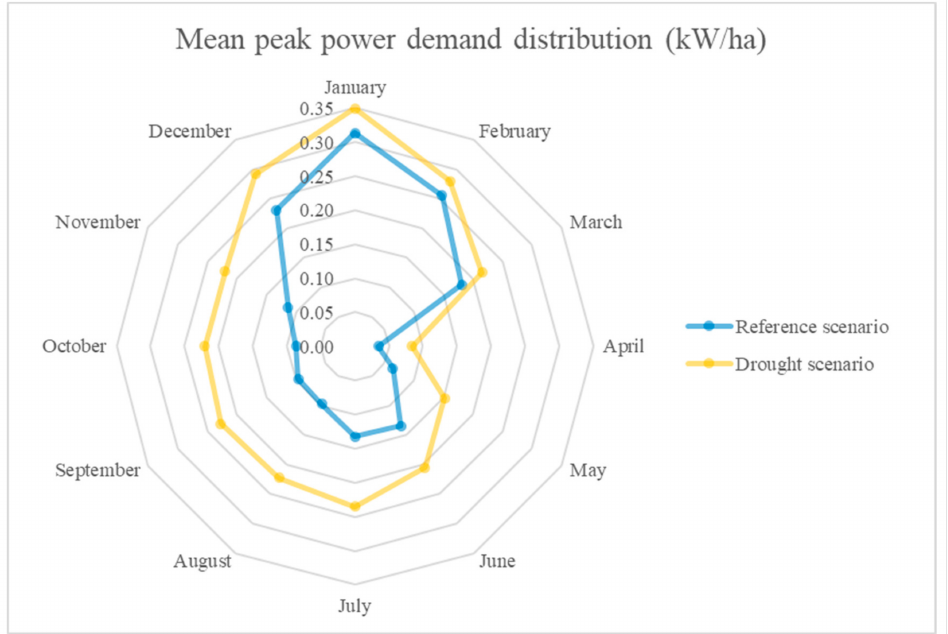
Figure 12. Mean peak power demand (kW/ha) distribution for irrigation water pumping across the year in the reference and drought